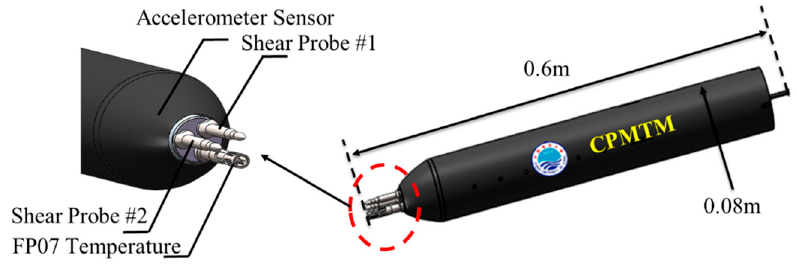
Figure 2. The schematic of the CPMTM, and an array of turbulence sensors in the nose.